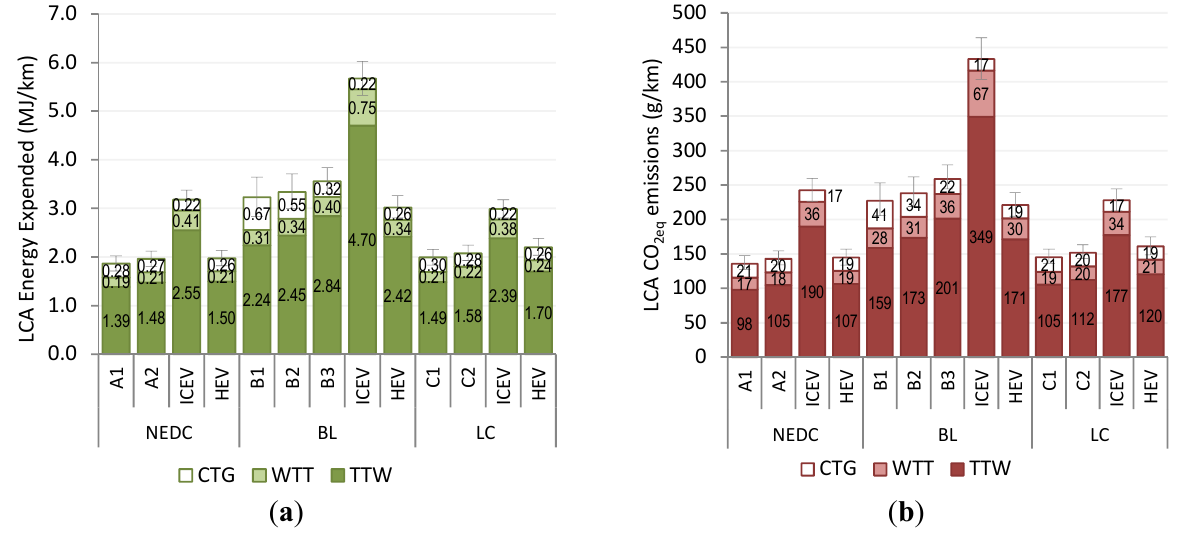
Figure 9. Life cycle energy use ( a ) and CO 2eq emissions ( b ), of the reference and optimal vehicles in NEDC, BL and LC driving cycles, for a lifetime distance of 550,000 km.